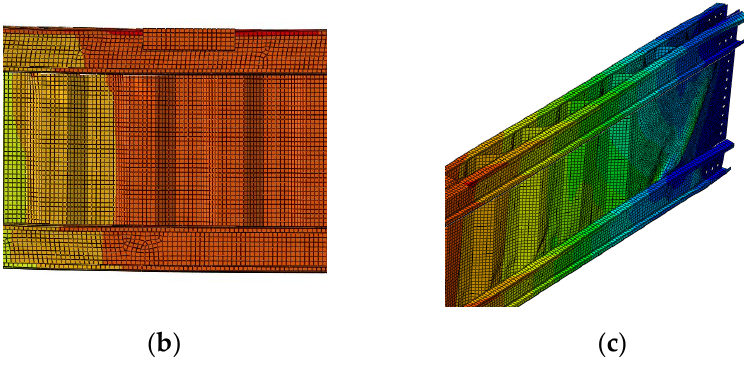
Figure 27. Comparison of failure modes in the final stage of loading for the beam with a web opening and a length of 6000 mm: ( a ) instability phenomena under the load application points for M1-6000 WO, i.e., the beam with the corrugated web thickness of 1.00 mm; ( b ) no instabilities were recorded under the load application points for M13-6000 WO, i.e., the beam with the corrugated web thickness of 1.50 mm; ( c ) failure of the M13-6000 WO beam was due to local buckling of the shear panels coupled with the distortion of the corrugations connected to the lower flange.